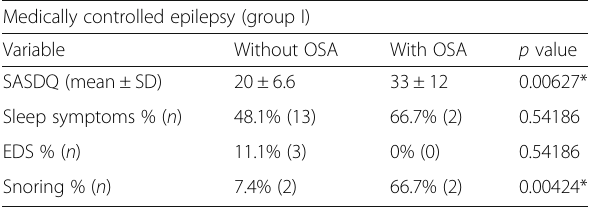
Table 6 Comparison between patients with and without OSA in group 1 regarding sleep